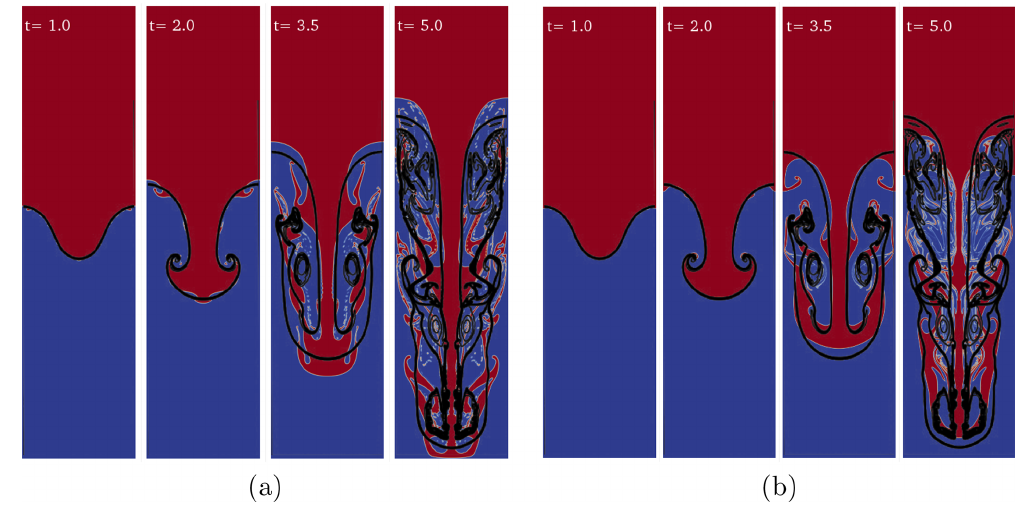
Figure 5. Rayleigh–Taylor instability ( A = 0 . 5, Re = 2048) computed with the OpenFOAM solver interFoam (in color) with (a) 256 × 1024 cells and the default value for the interface compression factor C α = 1 as well as (b) 512 × 2048 cells and C α = 0 . 1. The density field (color-coded) is compared with the density contours of He et al. (1999) (black lines).